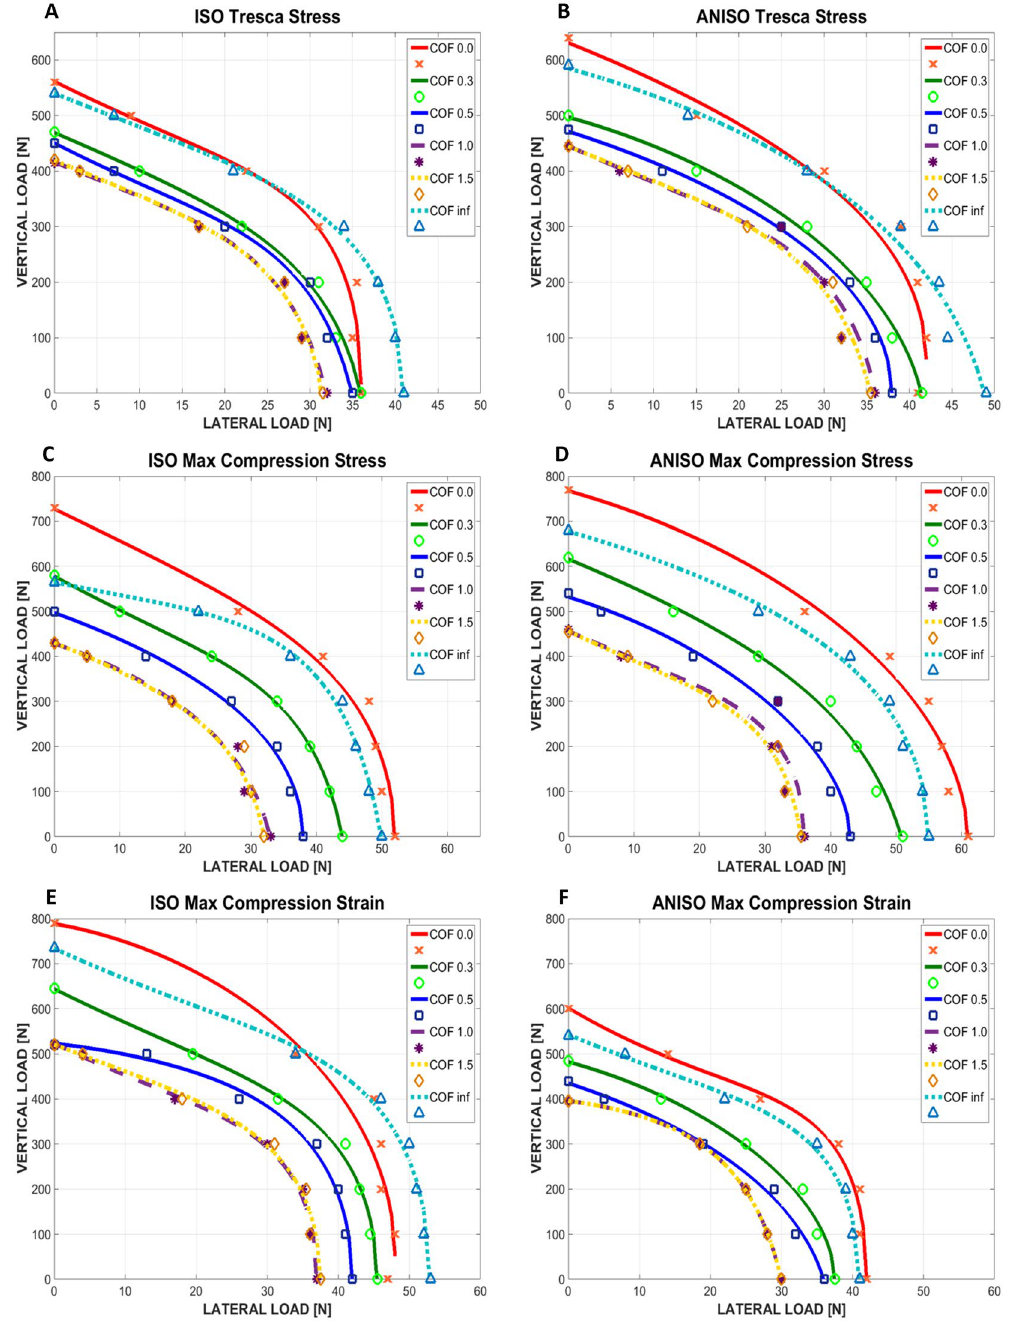
Figure 1. Graphs of lateral vs. vertical load causing cortical bone yielding. ( A , B ) Isotropic and anisotropic cortical bone respectively, for Tresca stress yield criterion. ( C , D ) Isotropic and anisotropic cortical bone respectively, for maximum compression stress yield criterion. ( E , F ) Isotropic and anisotropic cortical bone respectively, for maximum compression strain yield criterion. The coefficient of friction is marked as